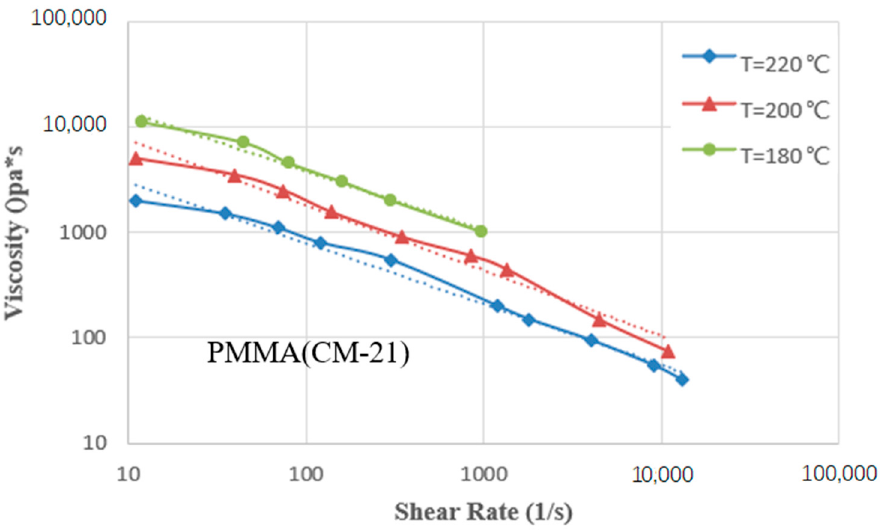
Figure 6. Experiment barrel screw for low melting polymer design. To prove the flexibility and effectiveness of the TVA method, three types of thermal- adaptive PMMA polymer alloy screws were processed in batches in the injection machine’s screw manufacturing unit. In this example, the average screw length (ASL) of the processed screw was used as the inspection item [28,29]. As Figure 7 compares the difference of molten plastic prediction under various calculation conditions.